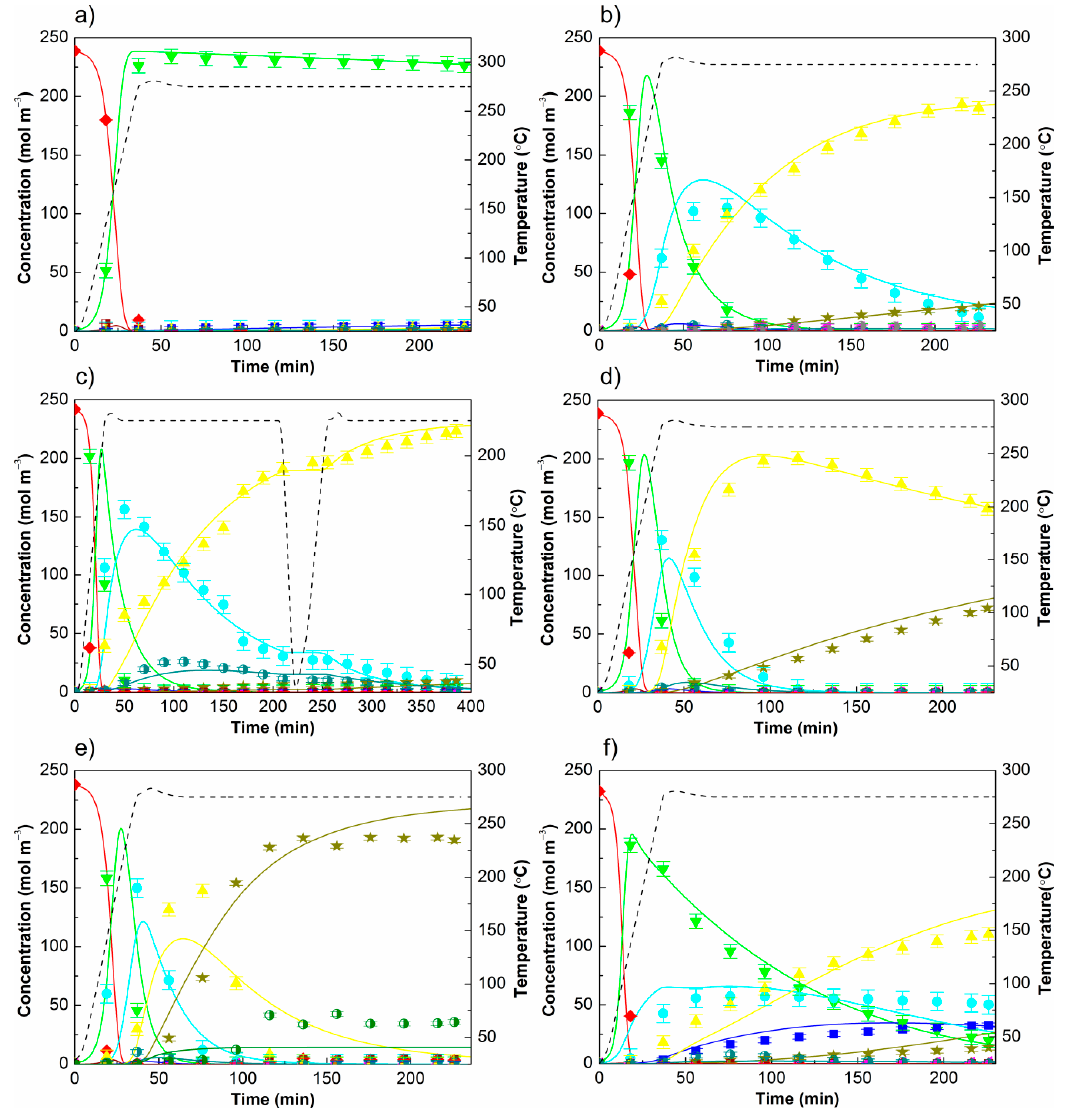
Figure 7. Experimental and model results for ( a ) Ru/C-Fe 2 O 3 , ( b ) Ru/C-Fe 2 O 3 -300, and ( c ) Ru/C-Fe 2 O 3 -500 at 225 °C, ( d ) Ru/C-Fe 2 O 3 -500 at 275 °C, ( e ) Ru/C-Fe 2 O 3 -600 and ( f ) Ru/C-Fe 2 O 3 -750. Meaning of